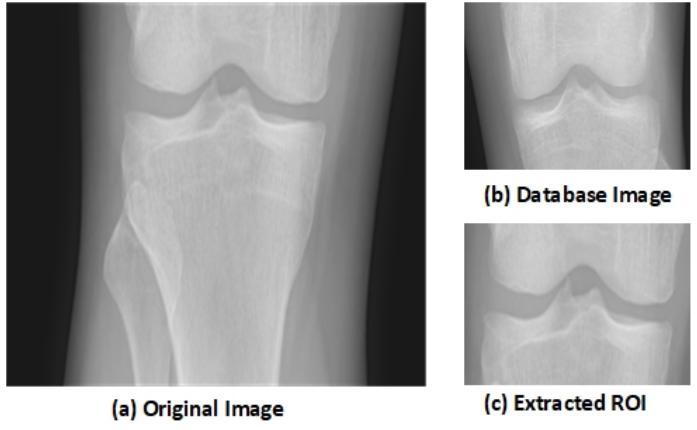
Figure 1. Extraction of Region of Interest (ROI)